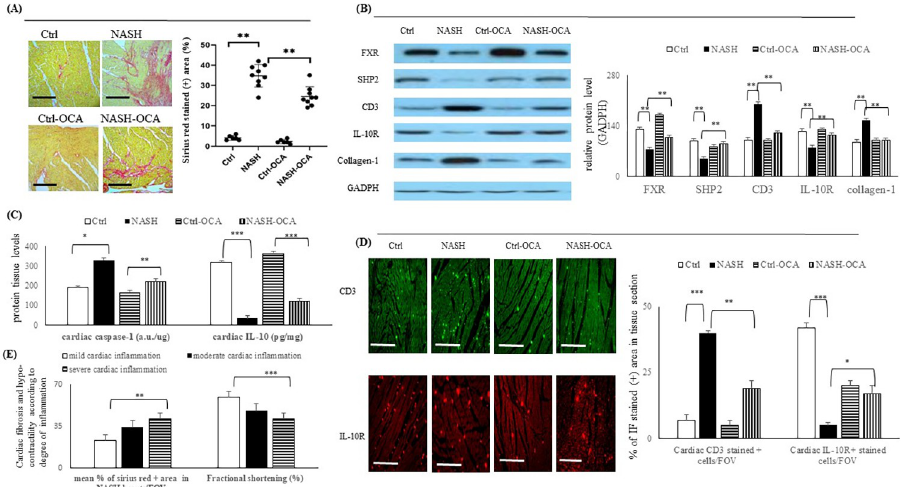
cardiac pathogenic protein markers expression. ( C ) Cardiac levels of caspase-1 and IL-10. ( D ) Mean degree of cardiac fibrosis and fraction of shortening among mice with mild, moderate, and severe cardiac inflammation. ( E ) Cardiac CD3 + T cells (green color) and IL-10R + Treg cells (red color) infiltration. �� , ��� : p < 0.01 or < 0.001 vs . Ctrl or NASH group.